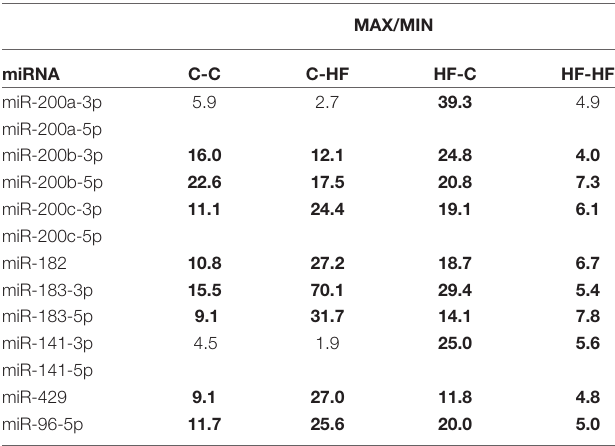
TABLE 2 | miRNAs specified by clusters miR-96/182/183, miR-141/200c, and miR-200a/200b/429 display hypervariable expression.